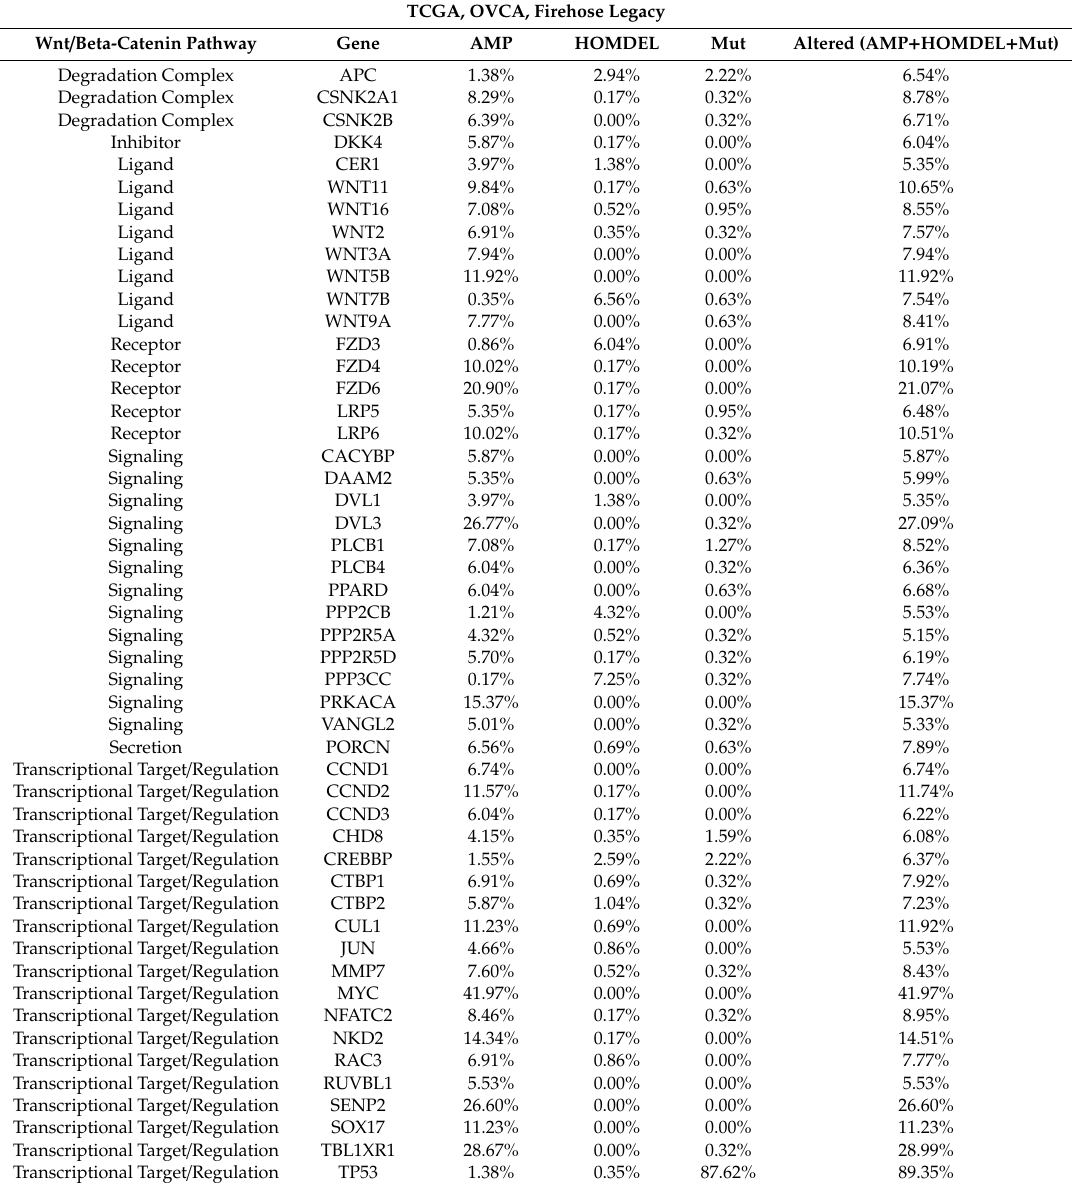
Table 1. Canonical and non-canonical Wnt / β -catenin signaling pathway alterations in high grade serous ovarian cancer. The Cancer Genome Atlas (TCGA), Firehose Legacy. Wnt / β -catenin KEGG Pathway (150 genes). AMP = amplification, HOMDEL = homozygous deletion, Mut =